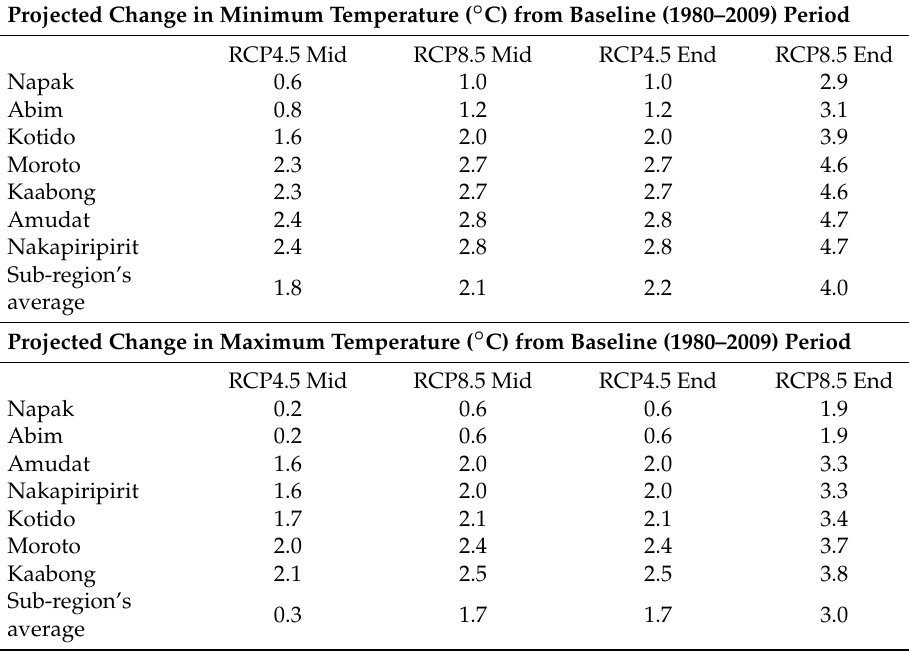
Table 6. Comparison of change in temperature from the baseline (1980–2009)